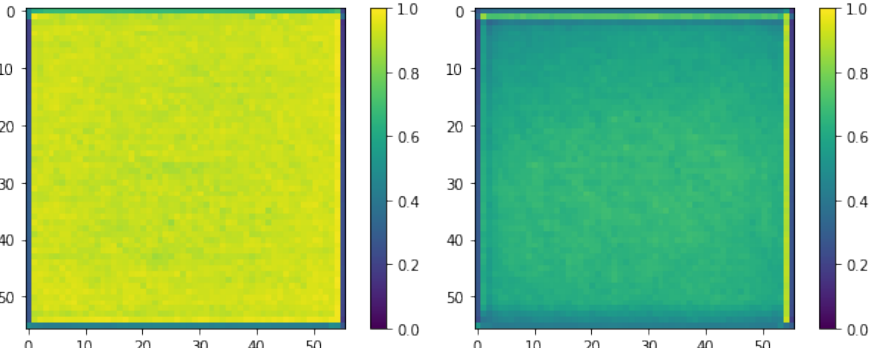
Figure A1. Cosine distance for the output of the original and decomposed layer1.1.bn1 . The fourth channel of the output tensor before ( left ) and after ( right ) BN calibration. Values inside the channel do not vary much, except for their